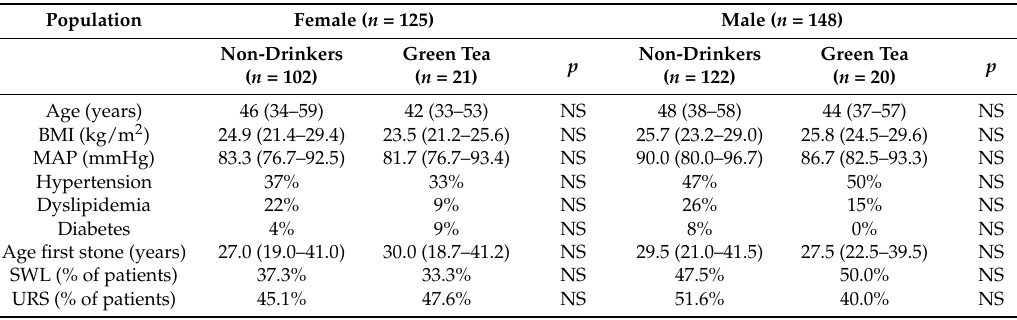
Table 1. Demographic and clinical